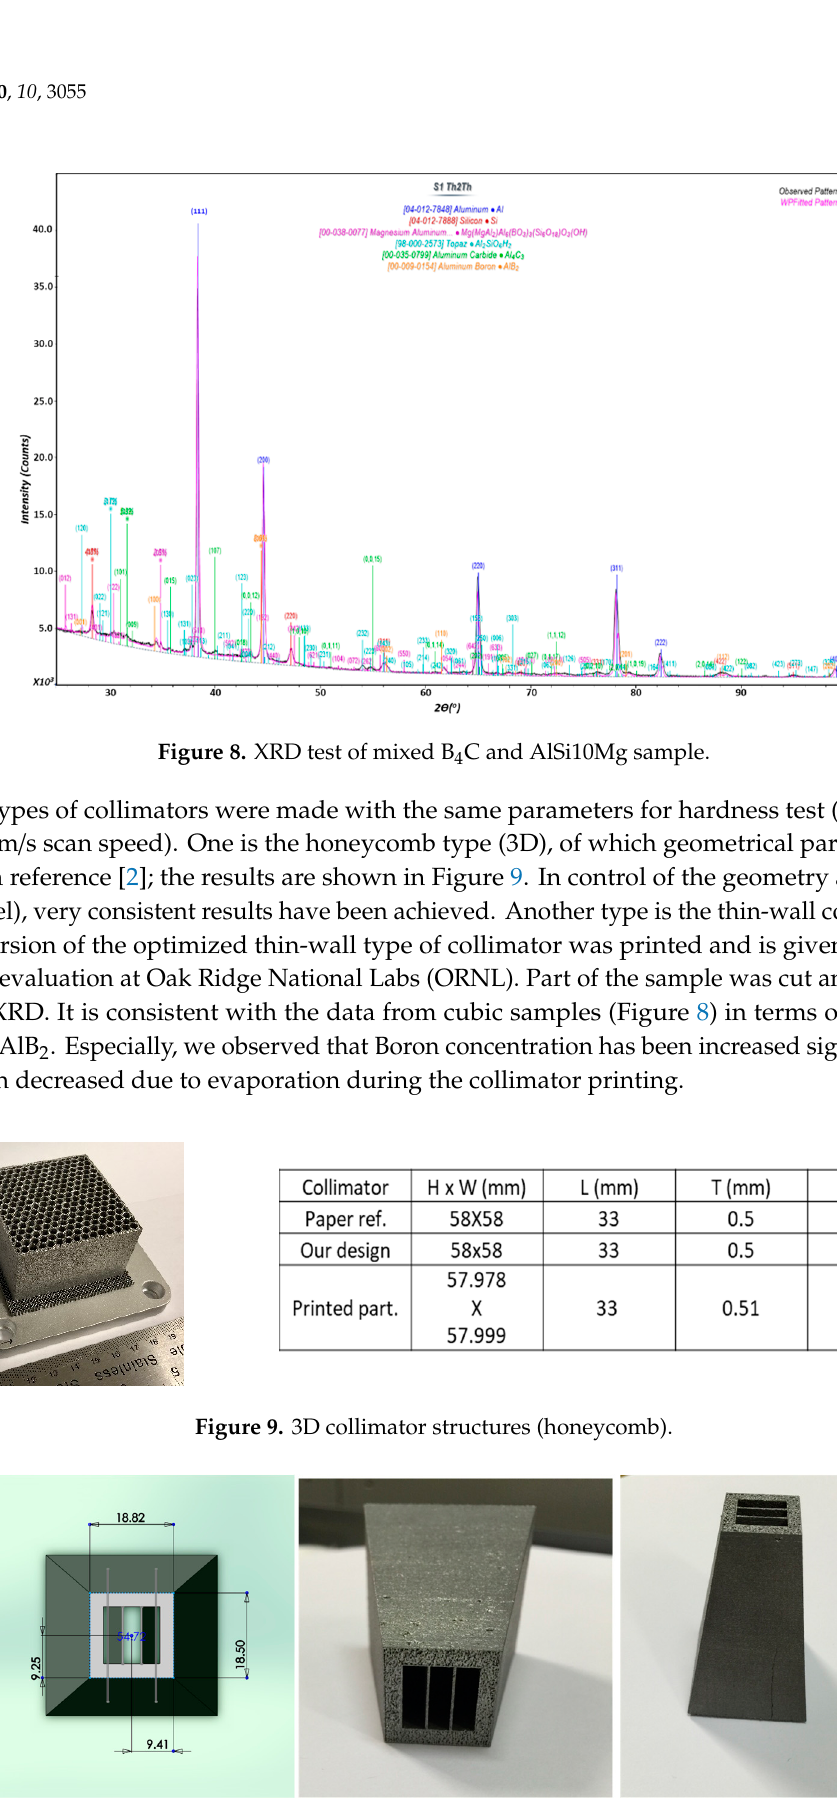
Figure 10. A small version of the optimized collimator design.